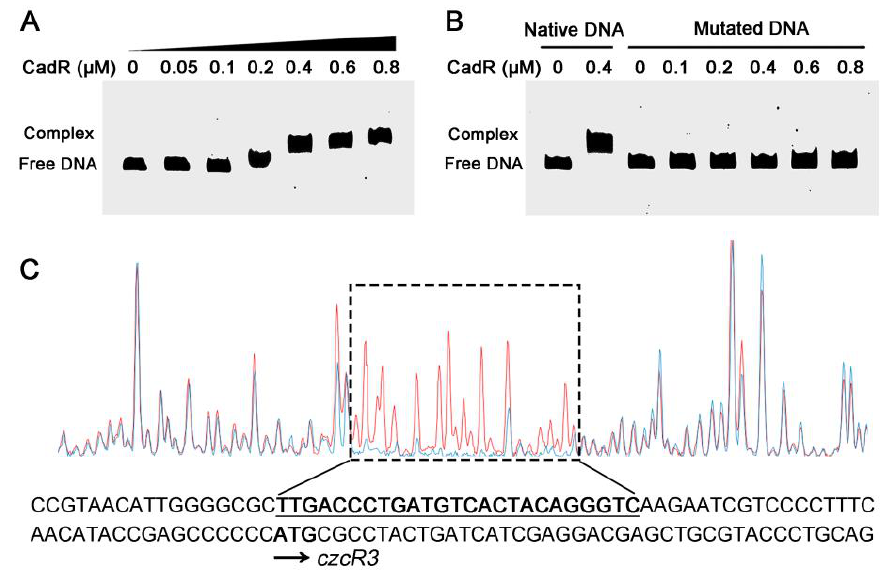
Figure 6. CadR directly binds to the czcRS3 promoter. The native ( A ) and mutated ( B ) probes of czcRS3 promoter were subjected to EMSA with the purified CadR. ( C ) The binding site of CadR on czcRS3 promoter was identified by DNase I footprinting assay, in which the native probe was incubated with CadR (blue peak) or BSA (red peak, as control). The region in the dashed box represents the binding region of CadR on czcRS3